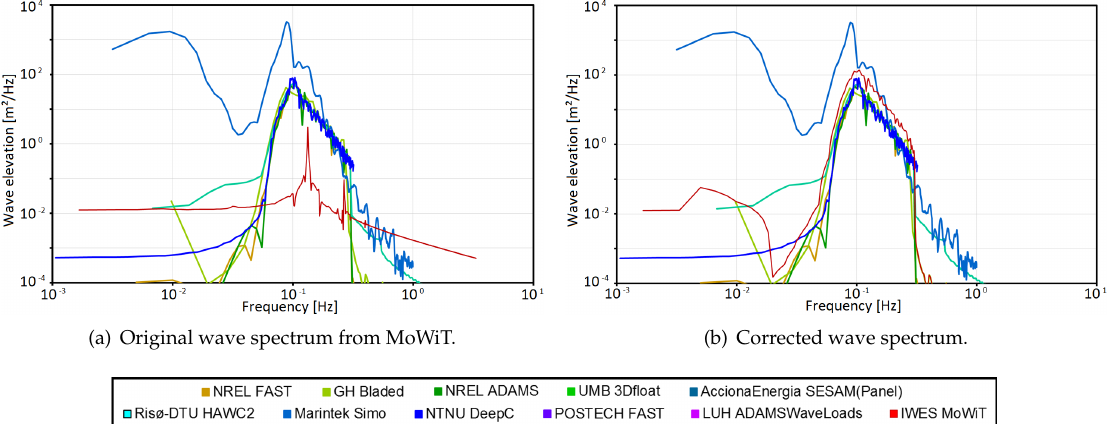
Figure 18. Wave power spectra for LC 4.2 in